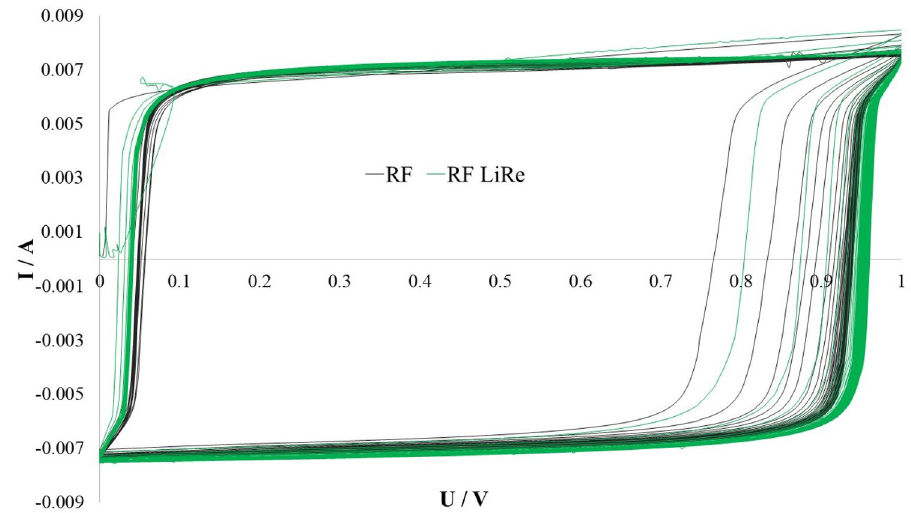
Fig. 5 CV curves for gels pre- pared with sodium carbonate (RF) and lithium perrhenate (RF LiRe) catalysts, registered in 1000 charge/discharge